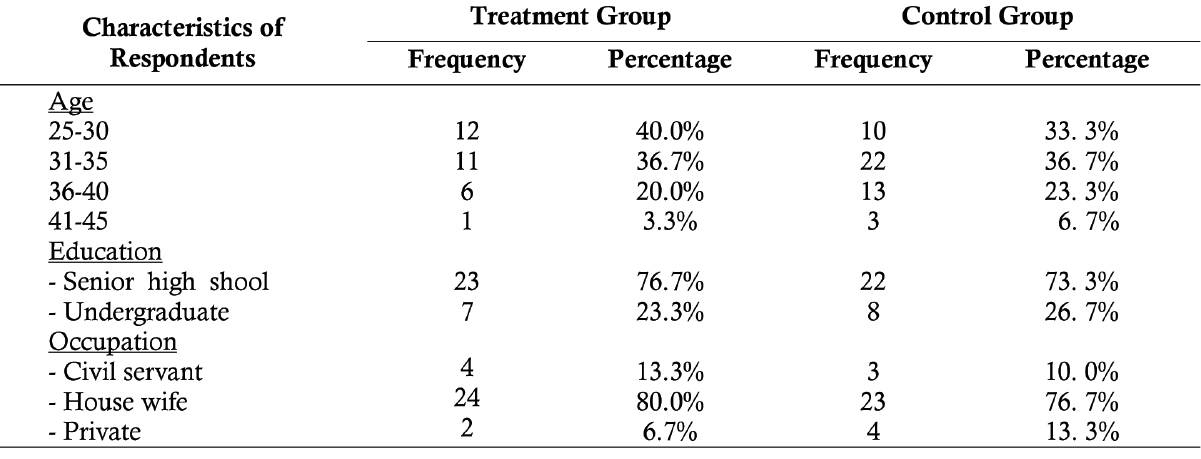
Table 1. Respondent